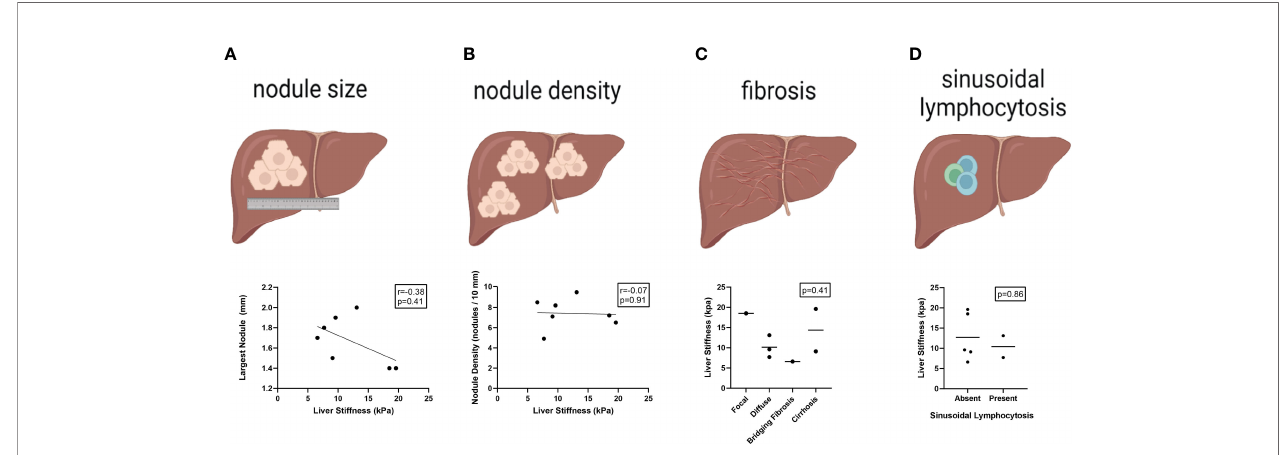
FIGURE 2 | Liver stiffness by transient elastography does not correlate with speci fi c histopathologic features of NRH in CVID patients. Liver stiffness measurements (kPa) by transient elastography compared across histopathologic features of NRH in CVID patients with available liver biopsy (N = 7), including size of largest nodule (A) , nodule density (B) , centrilobular fi brosis (C) , and sinusoidal lymphocytosis (D) . Signi fi cance by one-way ANOVA with Tukey ’ s post-hoc correction or Spearman ’ s correlation (r) with signi fi cance (p) shown. Line of best fi t (A, B) and mean value (C, D) are shown. NRH, nodular regenerative hyperplasia; CVID, common variable immunode fi ciency.